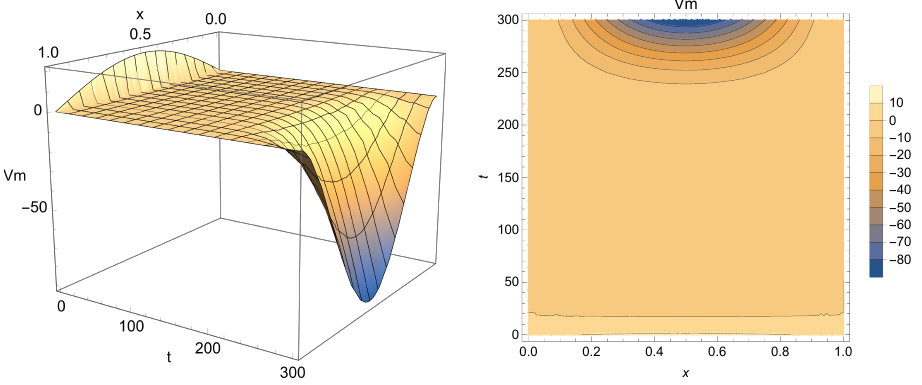
Figure 7. One-dimensional nonhomogeneous solution describing repolarization after the potential plateau: Equation (18) with α =